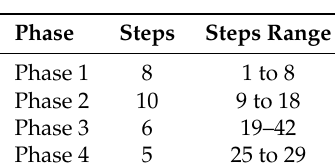
Table 1. Methodology phases and steps.